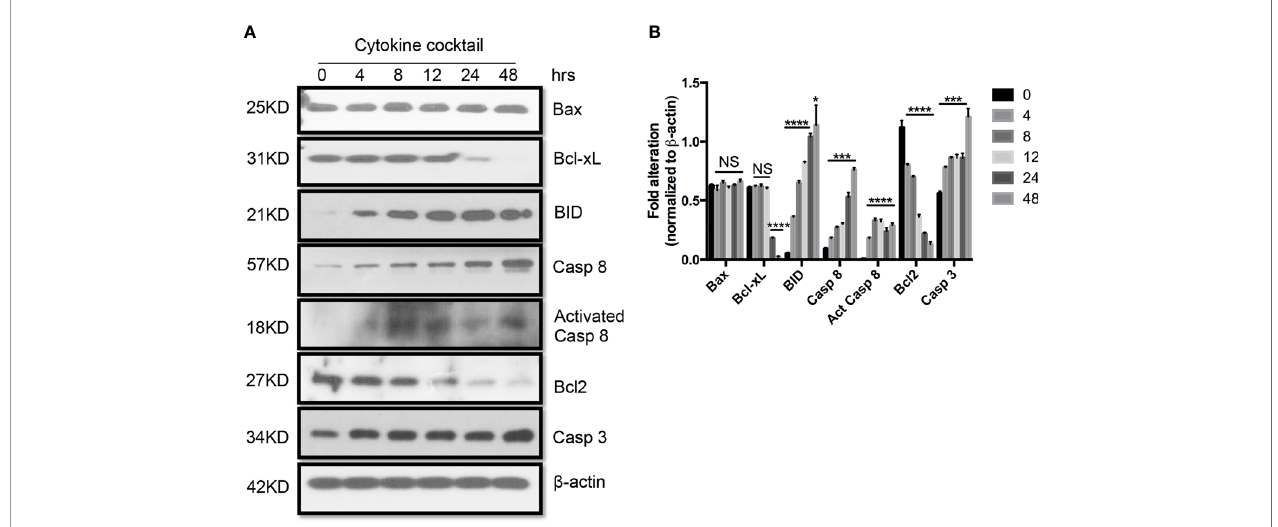
FIGURE 4 | Western blot analysis of apoptotic protein expression on primary human renal cortical epithelial cells challenged with cytokines. (A) The expression of Bcl2, Bcl-xL, BID; Bax caspase 3 and 8 (Casp 3 and 8), activated caspase 8 (Act Casp 8) in cells treated with cytokine cocktail. (B) Densitometric quantitation of proteins in (A) . All Western blots are representative of three independent experiments. NS, no signi fi cant, * P < 0.05, *** P < 0.0001, **** P < 0.00001 versus cells without treatment; analysis is multiple unpaired t-tests. Pairwise comparison of individual time-point to control indicated the same p-value.